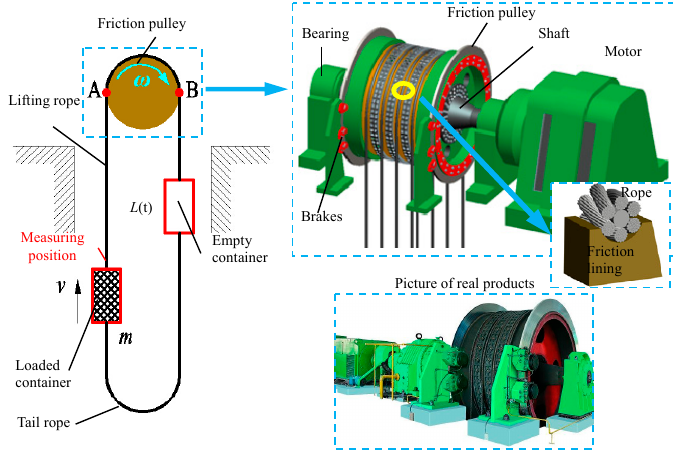
Figure 1. Schematic diagram of a large cage hoisting system in an auxiliary shaft of a coal mine.